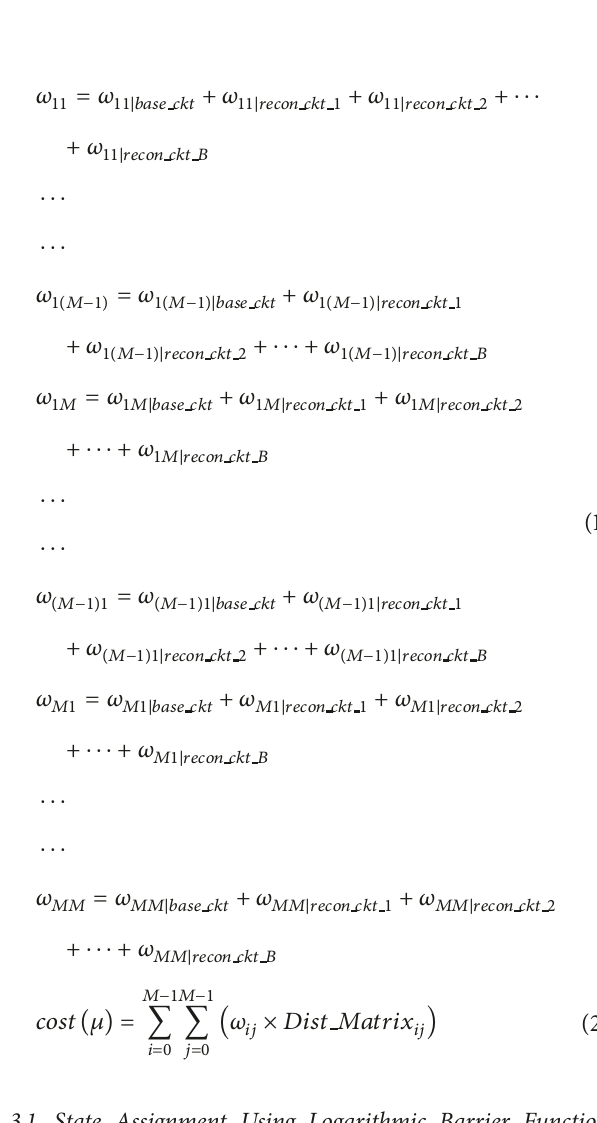
Figure 1: State transitions of each constituent FSM of the Reconfigurable FSMIM architecture at the last phase of iterative greedy heuristic based Hungarian algorithm